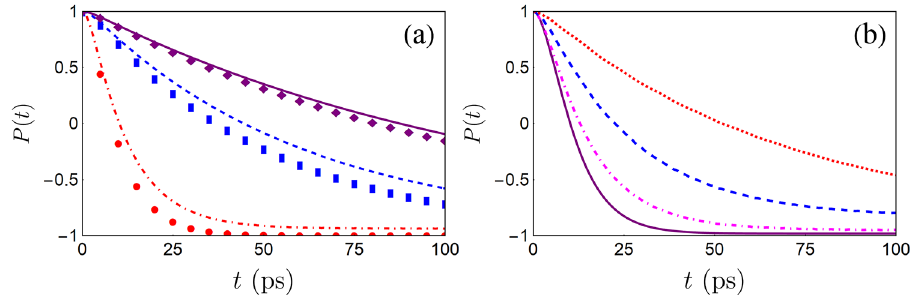
1 Figure 3. ( a ) P ( t ) with different coupling constants: α = 0.0025 cm − (purple solid line is the numerical 1 result from HEOM method, purple diamonds are analytical results from Eq. (10)), α = 0.005 cm − (blue dashed line is the numerical result from HEOM method, blue squares are analytical results from Eq. (10)) 1 and α = 0.025 cm − (red dotdashed line is the numerical result from HEOM method, red circles are 1 1 analytical results from Eq. (10)). Other parameters are chosen as ǫ = 1.5 cm − , (cid:31) = 0.05 , ω 0 = 5 cm − and ω c = 0.5 cm − 1 . ( b ) The dynamics P ( t ) from the HEOM method with different tunable parameters: (cid:31) = 0 (purple solid line), (cid:31) = 0.15 (magenta dotdashed line), (cid:31) = 0.25 (blue dashed line) and (cid:31) = 1 (red dotted line). 1 1 1 1 Other parameters are chosen as α = 0.025 cm − , ǫ = 1.5 cm − , ω 0 = 2.5 cm − and ω c = 0.35 cm −